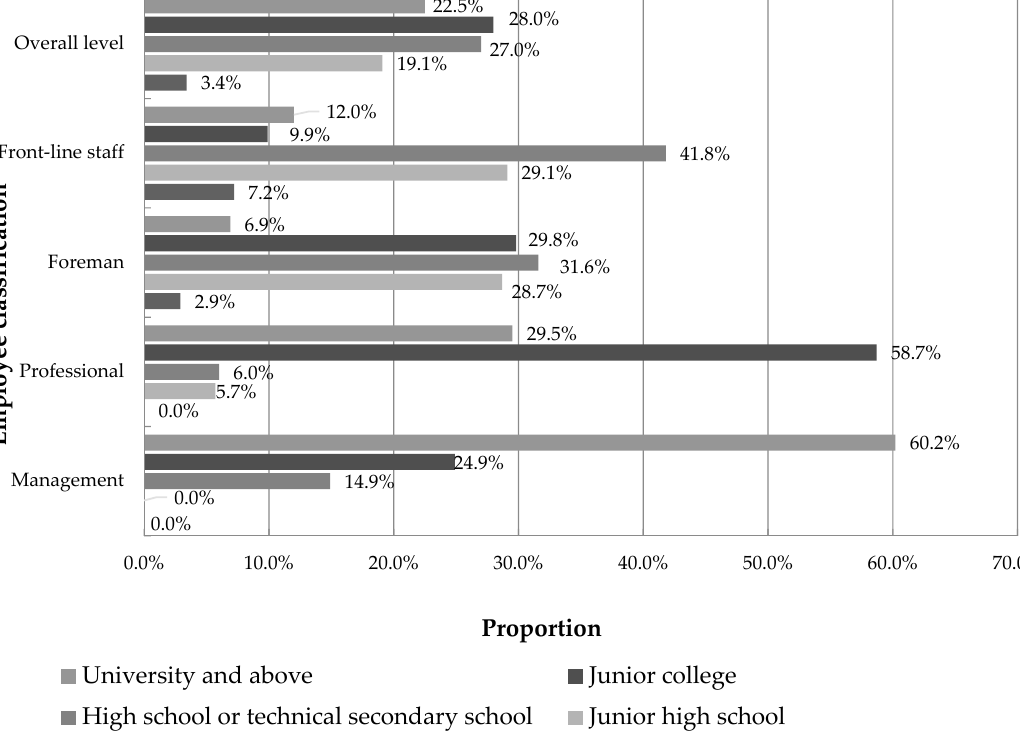
Figure 4. Basic information on the educational level of the tested employees.